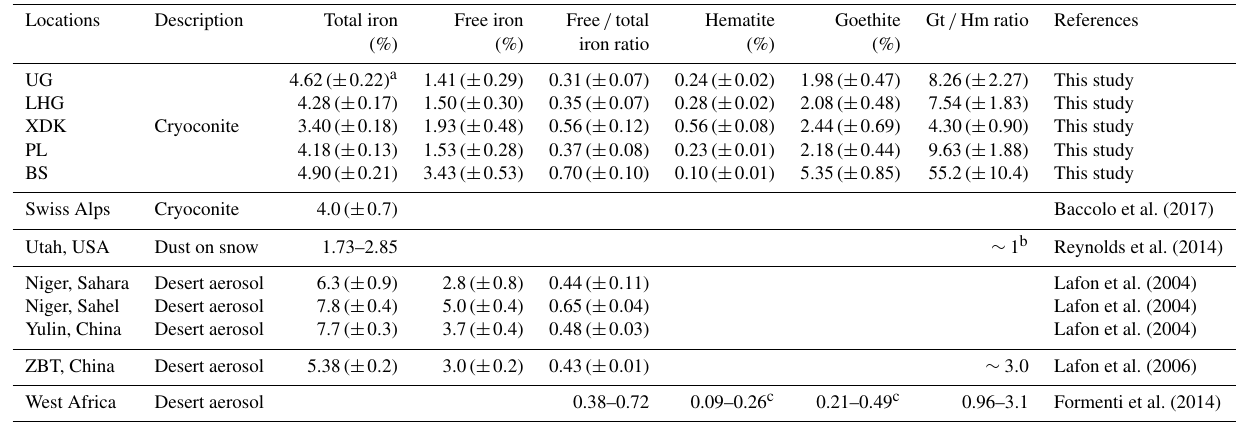
Table 2. The abundances (by mass) of total iron, free iron, hematite, goethite and their ratios determined in cryoconites from TP glaciers, as well as other data available in the literature.